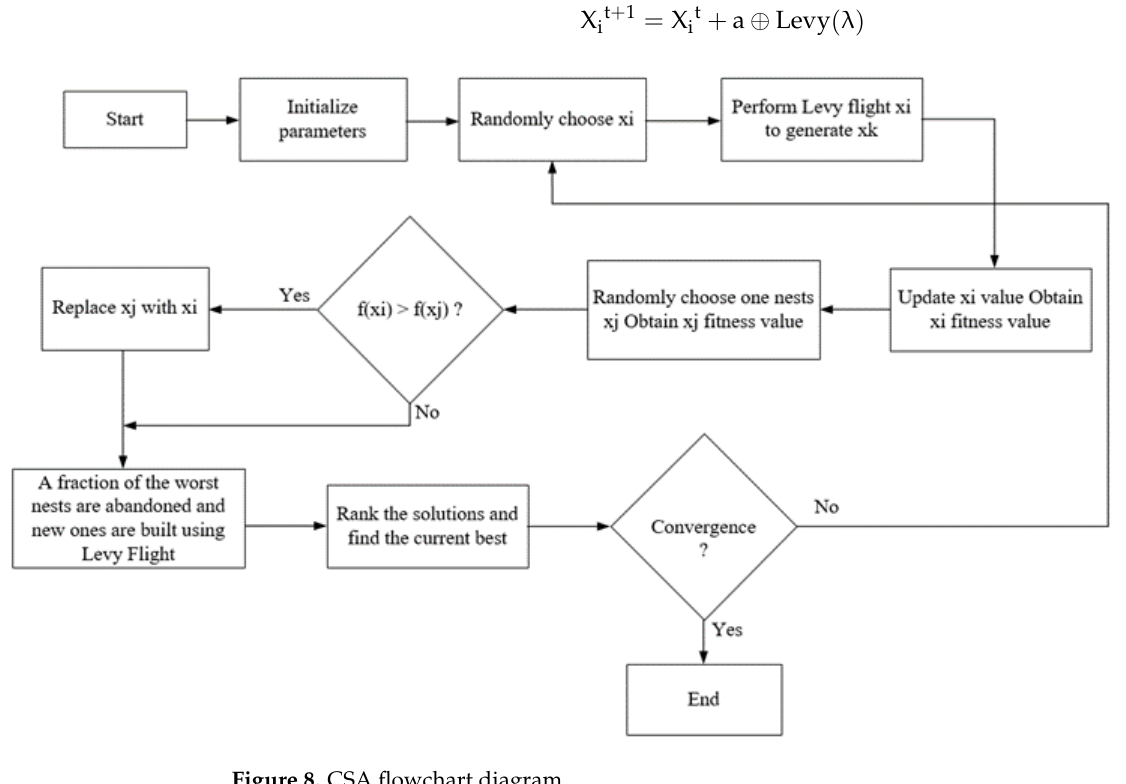
Figure 8. CSA flowchart diagram.